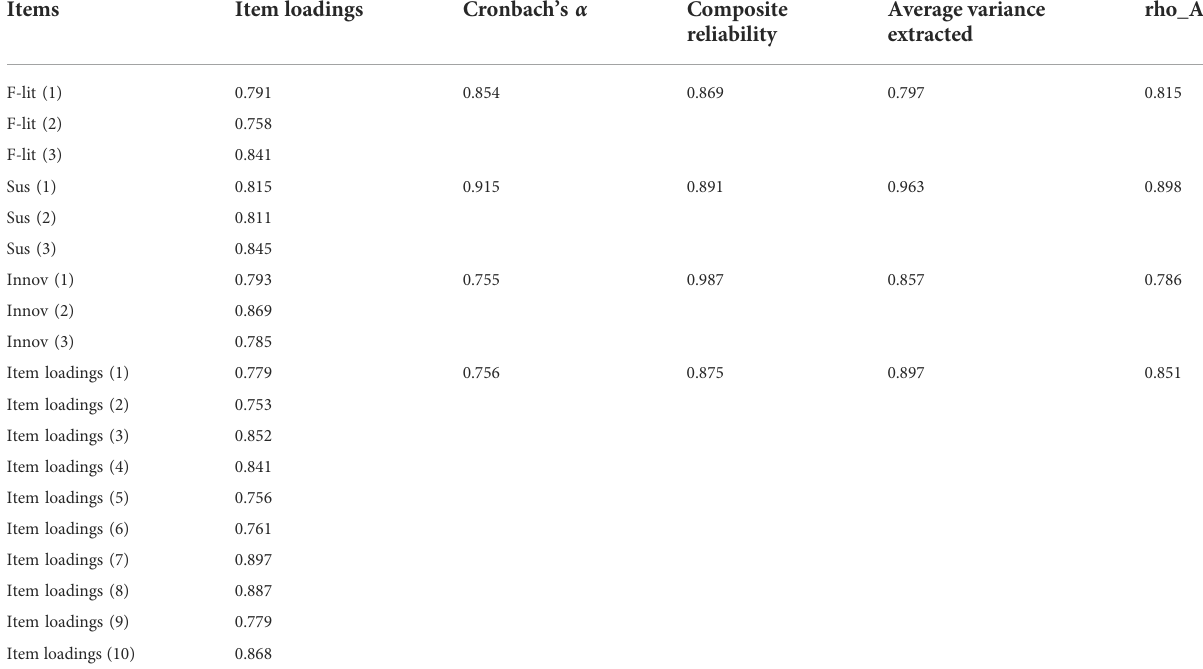
TABLE 2 Item loadings and consistency of hypothesis.